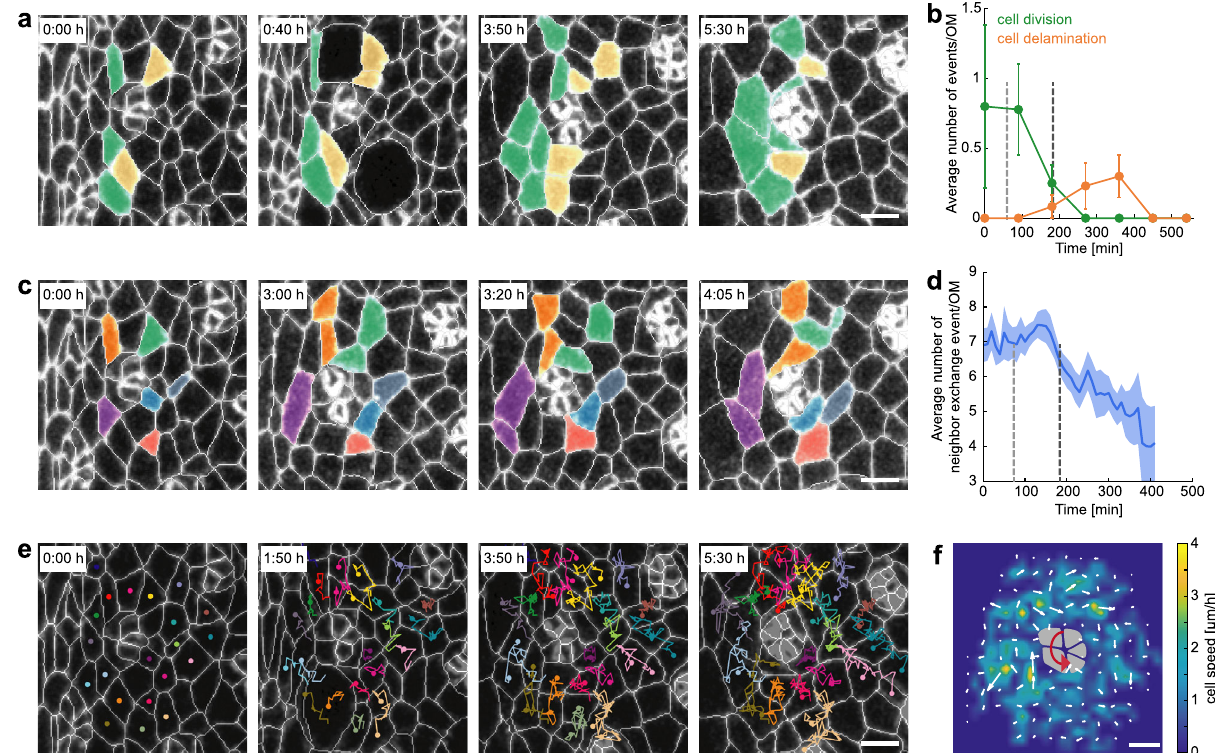
Fig. 2 Interommatidial cells display dynamic behaviors during ommatidial rotation. a Snapshots of the same cluster shown in Fig. 1 highlighting interommatidial cells (ICs) that divide (green) and delaminate (yellow; these cells can also divide, but at least one of the daughters delaminates subsequently). The ICs analyzed were fi rst level neighbors of the cluster at the R7 recruitment stage. b Average number of dividing (green) and delaminating (orange) ICs that were the fi rst-level neighbors of the photoreceptor cluster, as a function of time. Data were binned into 90 min time periods and were averaged over all ommatidia. The mean and standard error of the mean is shown. Gray dashed lines indicate the recruitment of the R1/R6 pair and R7, respectively (also in d ). c Selected ICs, highlighted with random colors, illustrating junction remodeling and neighbor exchange. d Average number of ICs that were the fi rst-level neighbors of the photoreceptor cluster and underwent neighbor exchange in between frames plotted as a function of time. Line shows mean, and shaded region indicates standard error of the mean. e Snapshots with trajectories of IC centroids, with dots representing the current centroid position in the respective image. f Average cell speed and displacement of ICs during ommatidial rotation. The trajectories of ICs from all ommatidia were pooled, and the average displacement (white arrows) and cell speed (heat map) were measured. A 5-cell pre-cluster schematic with gray cells is indicated in the middle of the plot with a curved red arrow representing the direction of rotation. Measurements in b , d , and f are averaged over 11 clusters from two pupae in >300 min movies. All scale bars: 3 µ